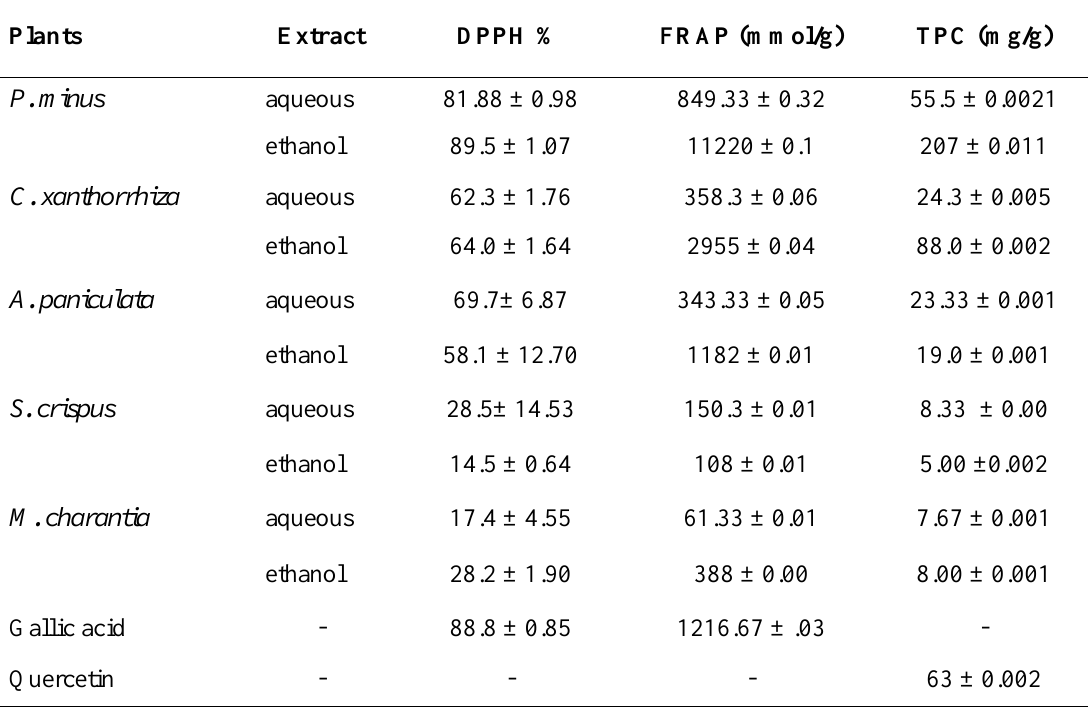
Table 1. Antioxidant properties and total phenolic content (TPC) of aqueous and ethanolic extract of five Malaysian plants. Each value represents mean ±